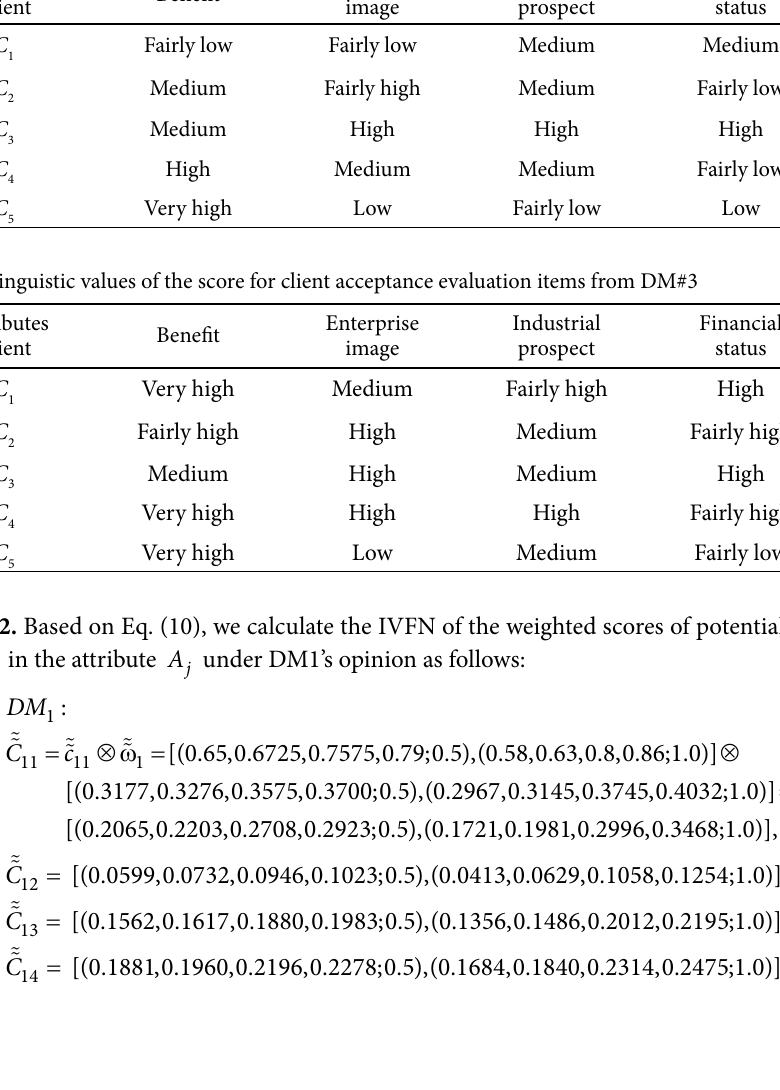
Table 5. Linguistic values of the score for client acceptance evaluation items from DM#2 Attributes Client